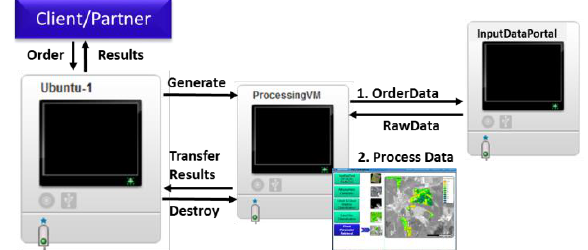
Figure 6. Workflow of automated upscaling for processing of datasets